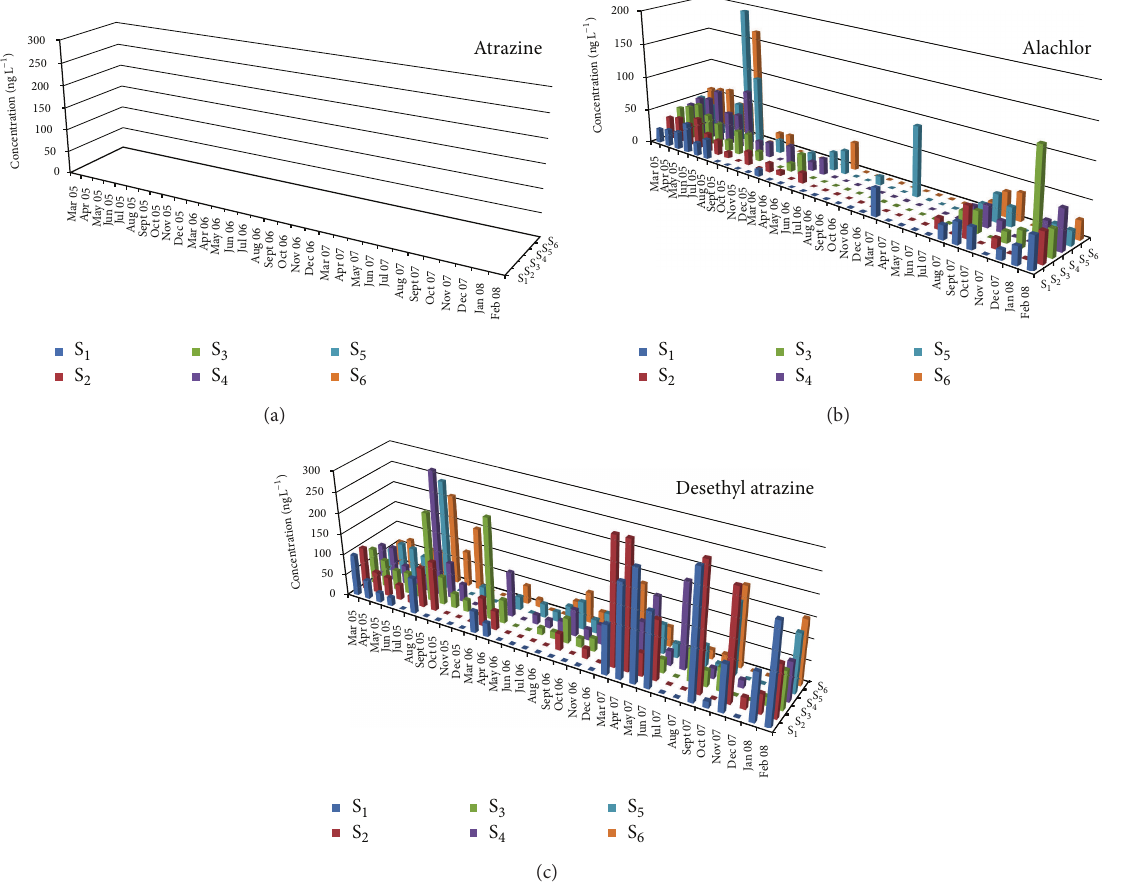
Figure 2: Temporal and spatial distribution of selected herbicide (atrazine (a), alachlor (b)) and metabolites (DEA (c)) concentrations during the sampling period (March 2005–February 2008) for the six sampling sites.